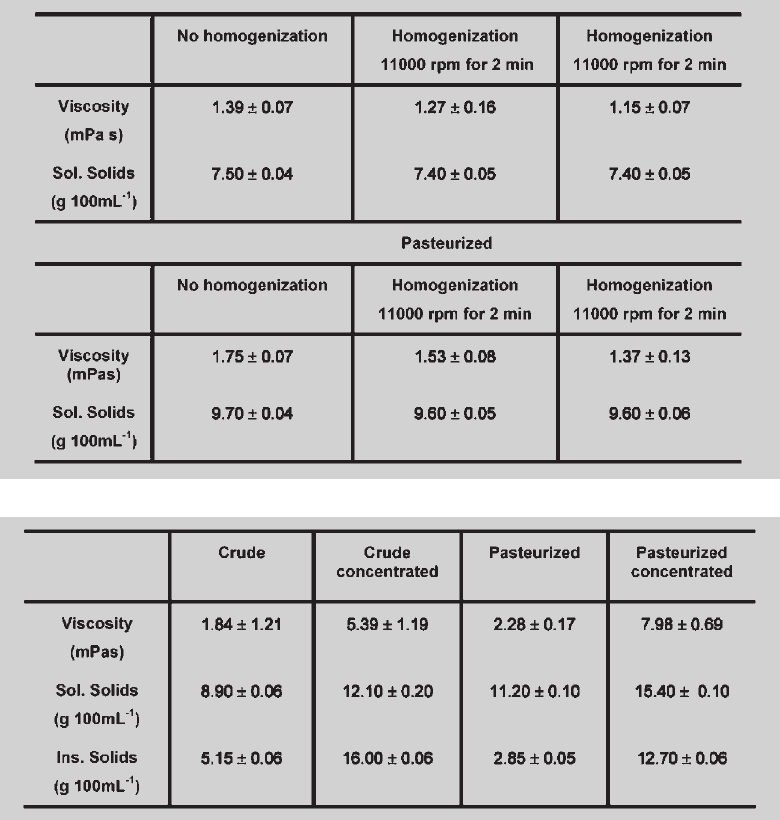
Table 3 (above): Viscosity (mPa·s) and soluble solid content (g100 mL -1 ) for filtrated, crude and pasteurized pulp. Table 4: Viscosity (mPa·s) and solu- ble solid content (g 100mL -1 ) for concentrated, crude and pasteurized pulp.